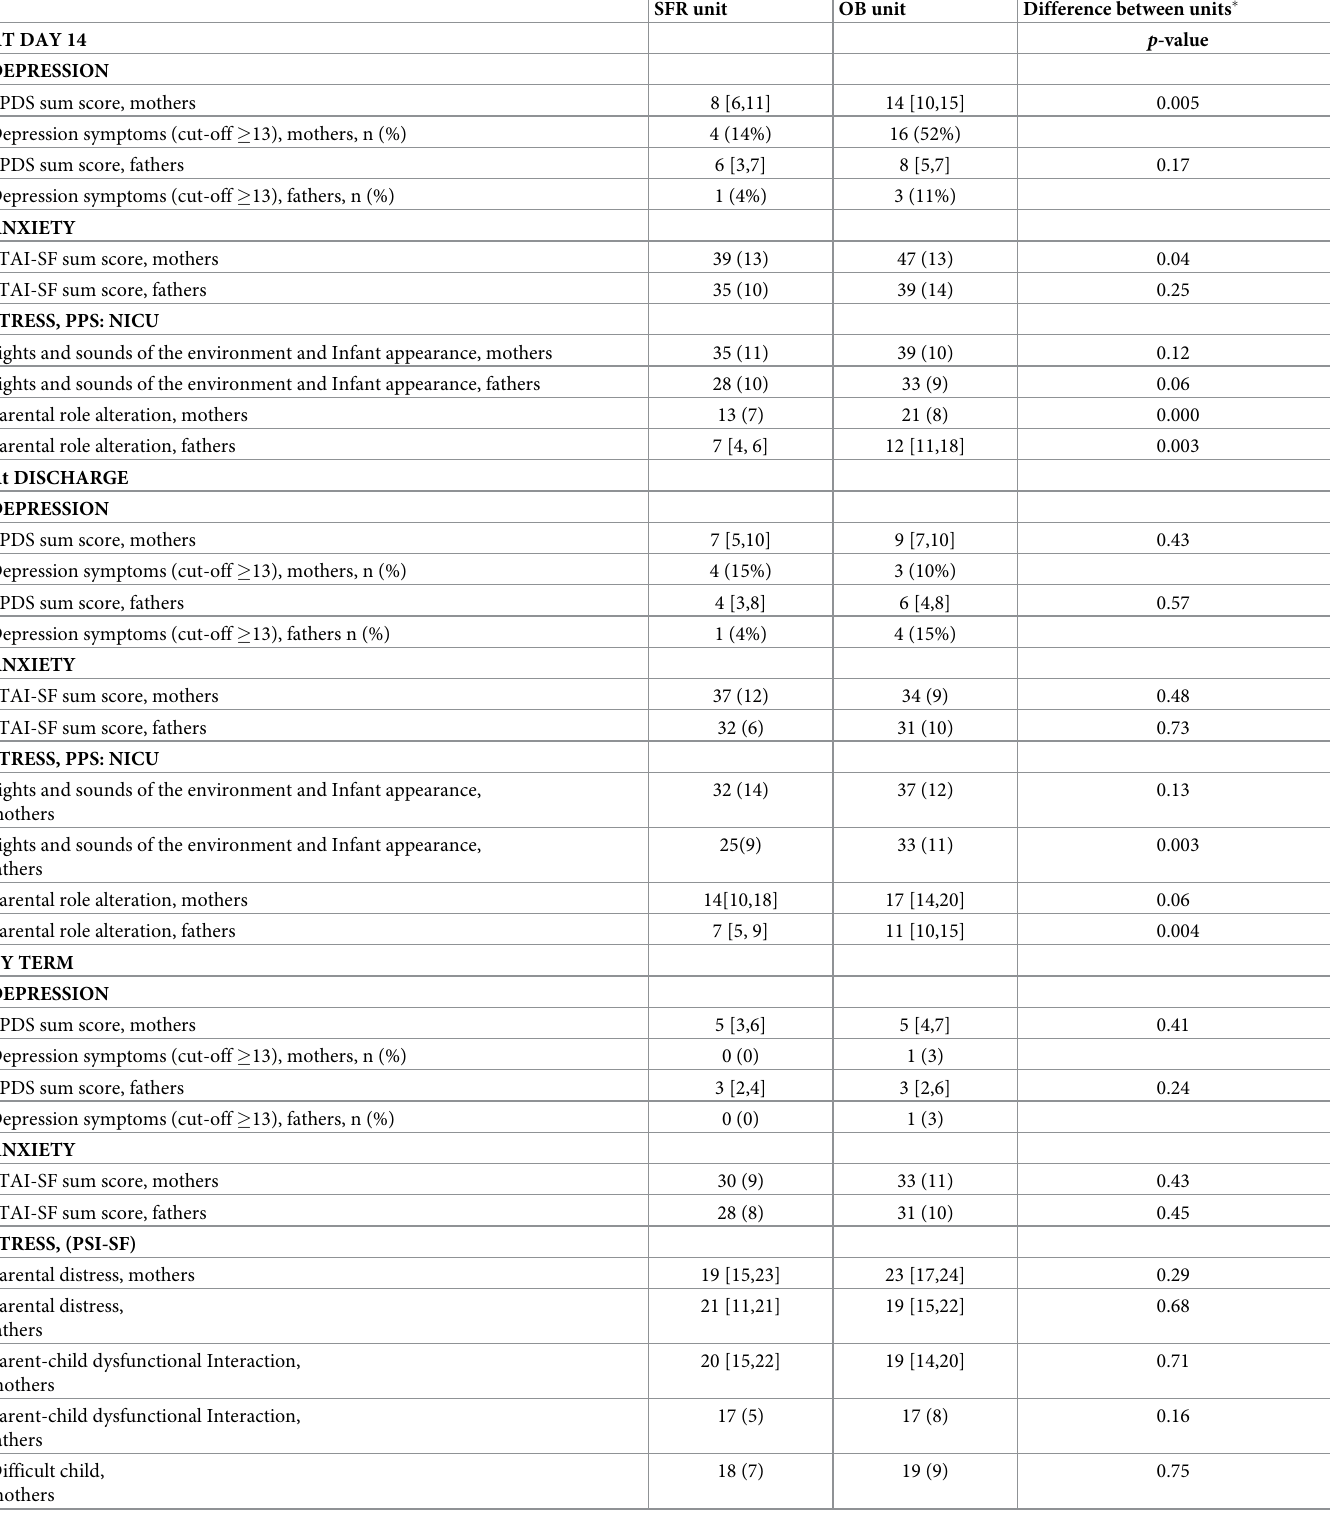
Table 3. Mothers’ and fathers’ scores of depression, anxiety, stress and attachment, presented as means (SDs), median [Q1, Q3] or number (%) within each unit. SFR unit OB unit Difference between units � AT DAY 14 p-